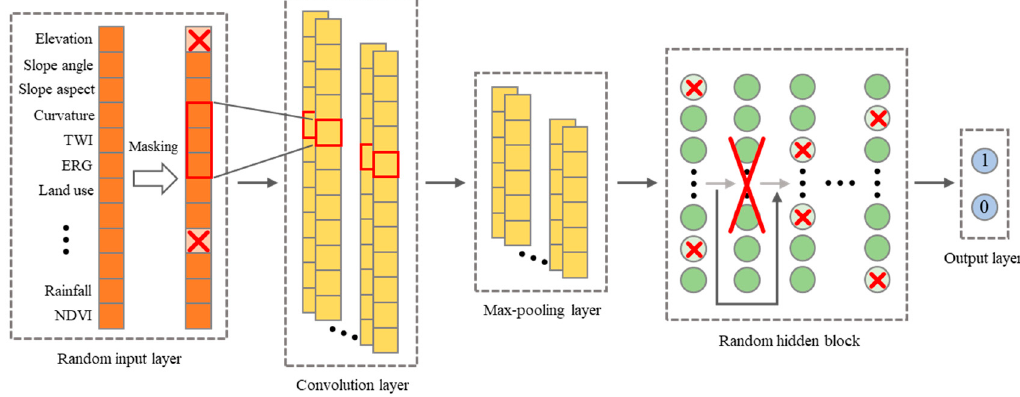
Figure 1. The whole architecture of the proposed DRNN.